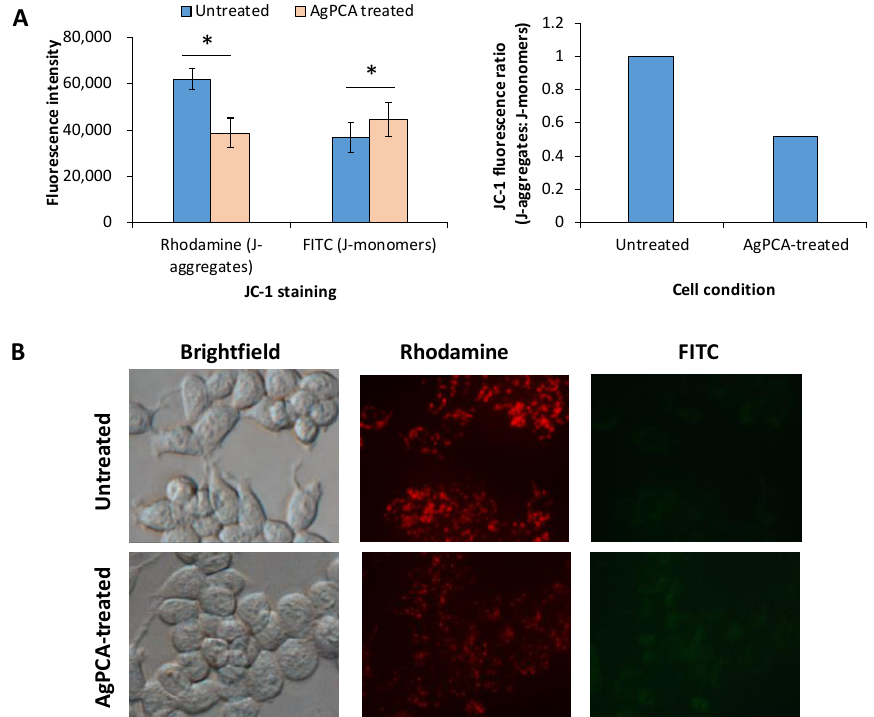
Figure 9. Mitochondrial membrane potential analysis of untreated control and AgPCA-treated HCT116 cells. ( A ) Fluorescence intensity (left) and fluorescence ratio of J-aggregates (rhodamine) to J-monomers (FITC) (right). Data are expressed as mean + standard deviation for triplicates within an individual experiment. Statistical significance was performed using Student’s t test. (* p < 0.05). ( B ) Fluorescence microscopy of JC-1 staining. FITC (diffuse green J-monomers) indicates the unhealthy status while rhodamine (red mitochondrial J-aggregates) indicates the healthy status. Images were captured at magnification of 40X.